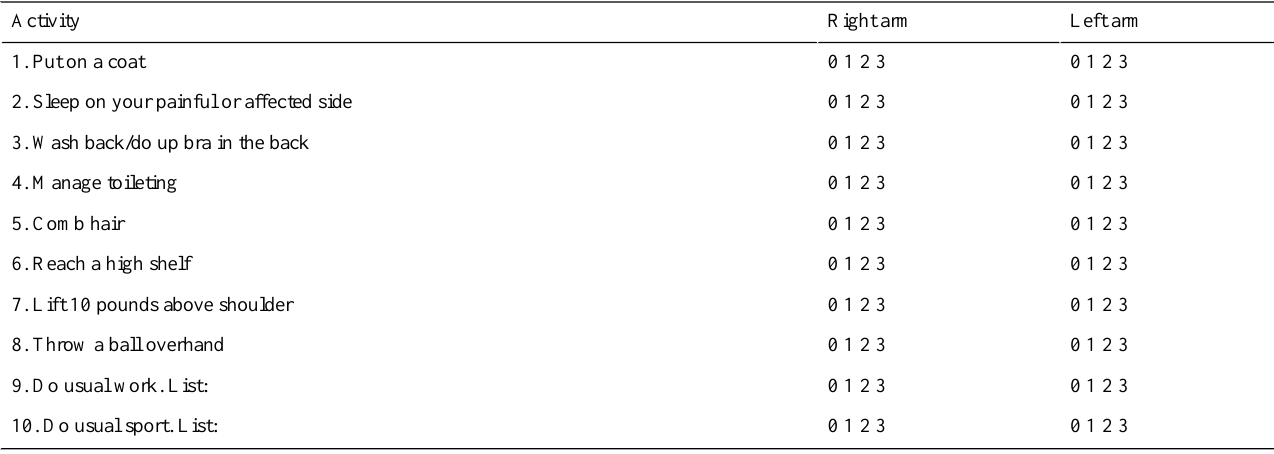
Table 1. Patient self-evaluation: activities of daily living questionnaire a